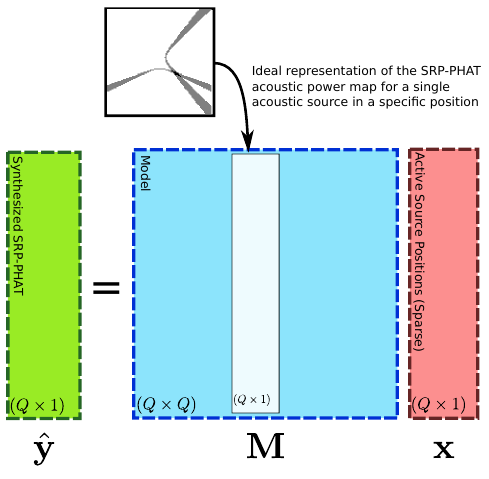
Figure 5. Explicit matrix layout for the model proposal given by Equation